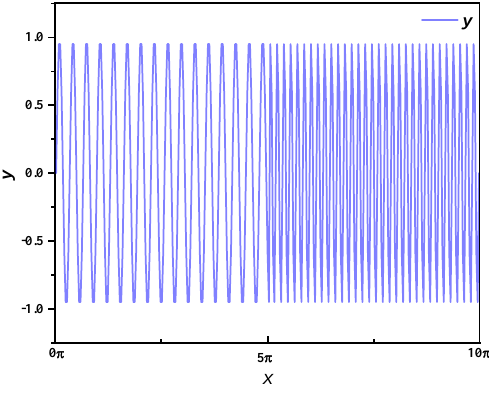
Figure 10. Time frequency waveform of the signal.